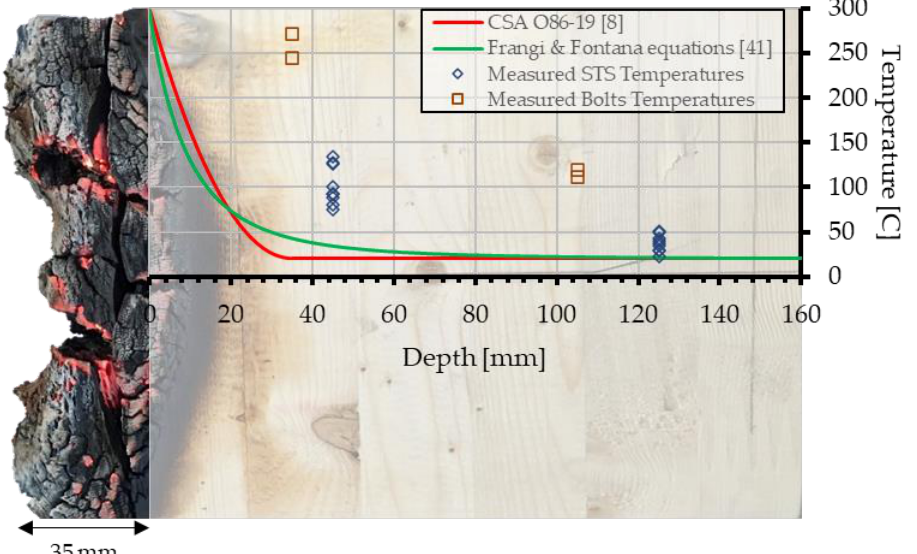
Figure 13. Measured temperatures and temperature profiles calculated according to [8,41] after hour for unprotected fastener heads exposed and 35 mm of char one hour for unprotected fastener heads exposed and 35 mm of char layer.